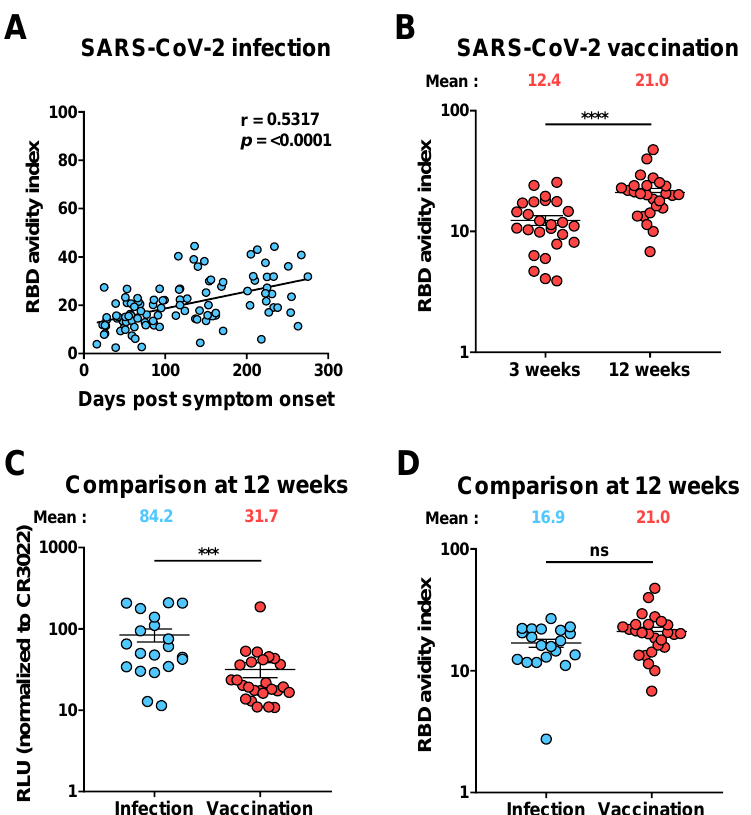
Figure 3. RBD avidity increases with time after SARS-CoV-2 infection and vaccination. ( A ) A positive correlation was found between time and avidity in convalescent donors after SARS-CoV-2 infection. ( B ) RBD avidity index measured in naïve vaccinated donors 3 and 12 weeks after the first dose of SARS-CoV-2 mRNA vaccine. Comparison of the anti-RBD IgG levels ( C ) and the RBD avidity index ( D ) at 12 weeks PSO or post vaccination. Convalescent and vaccinated donors are represented by blue and red points, respectively. Statistical significance was tested using Spearman correlation test ( A ), Wilcoxon paired t-test ( B ) and Mann–Whitney unpaired t-test ( C , D ). Error bars indicate means ± SEM. (*** p < 0.001; **** p < 0.0001; ns, non-significant).